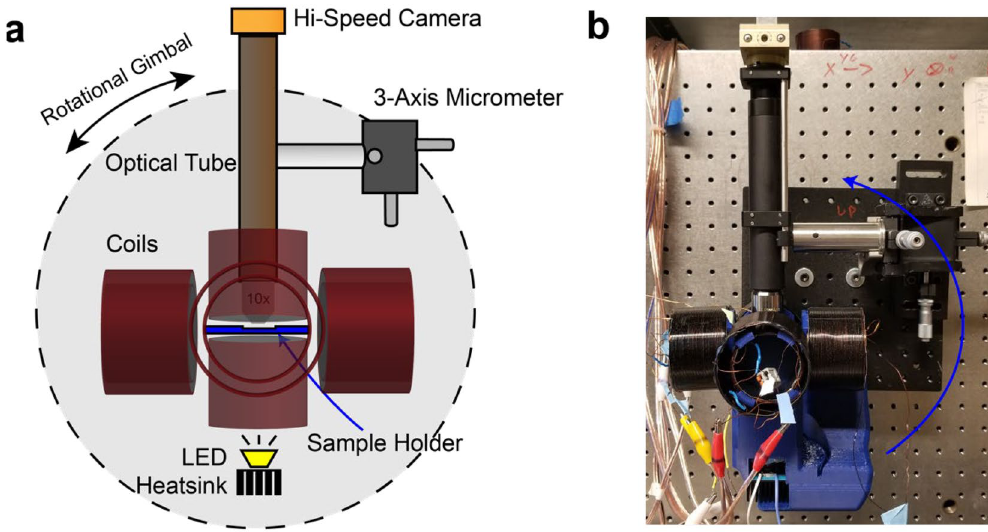
Figure 6. Rotating microscope and actuation apparatus, created and annotated using Illustrator (Adobe). ( a ) Diagram depicting the optical train and coils. 10 coils in total are depicted here, with 2 sets of concentric coils on the x and y axes and 2 individual coils on the z axis. ( b ) Fabricated apparatus. The body is 3D-printed out of poly-lactic acid (PLA) polymer while the gimbal is mounted behind the black optical